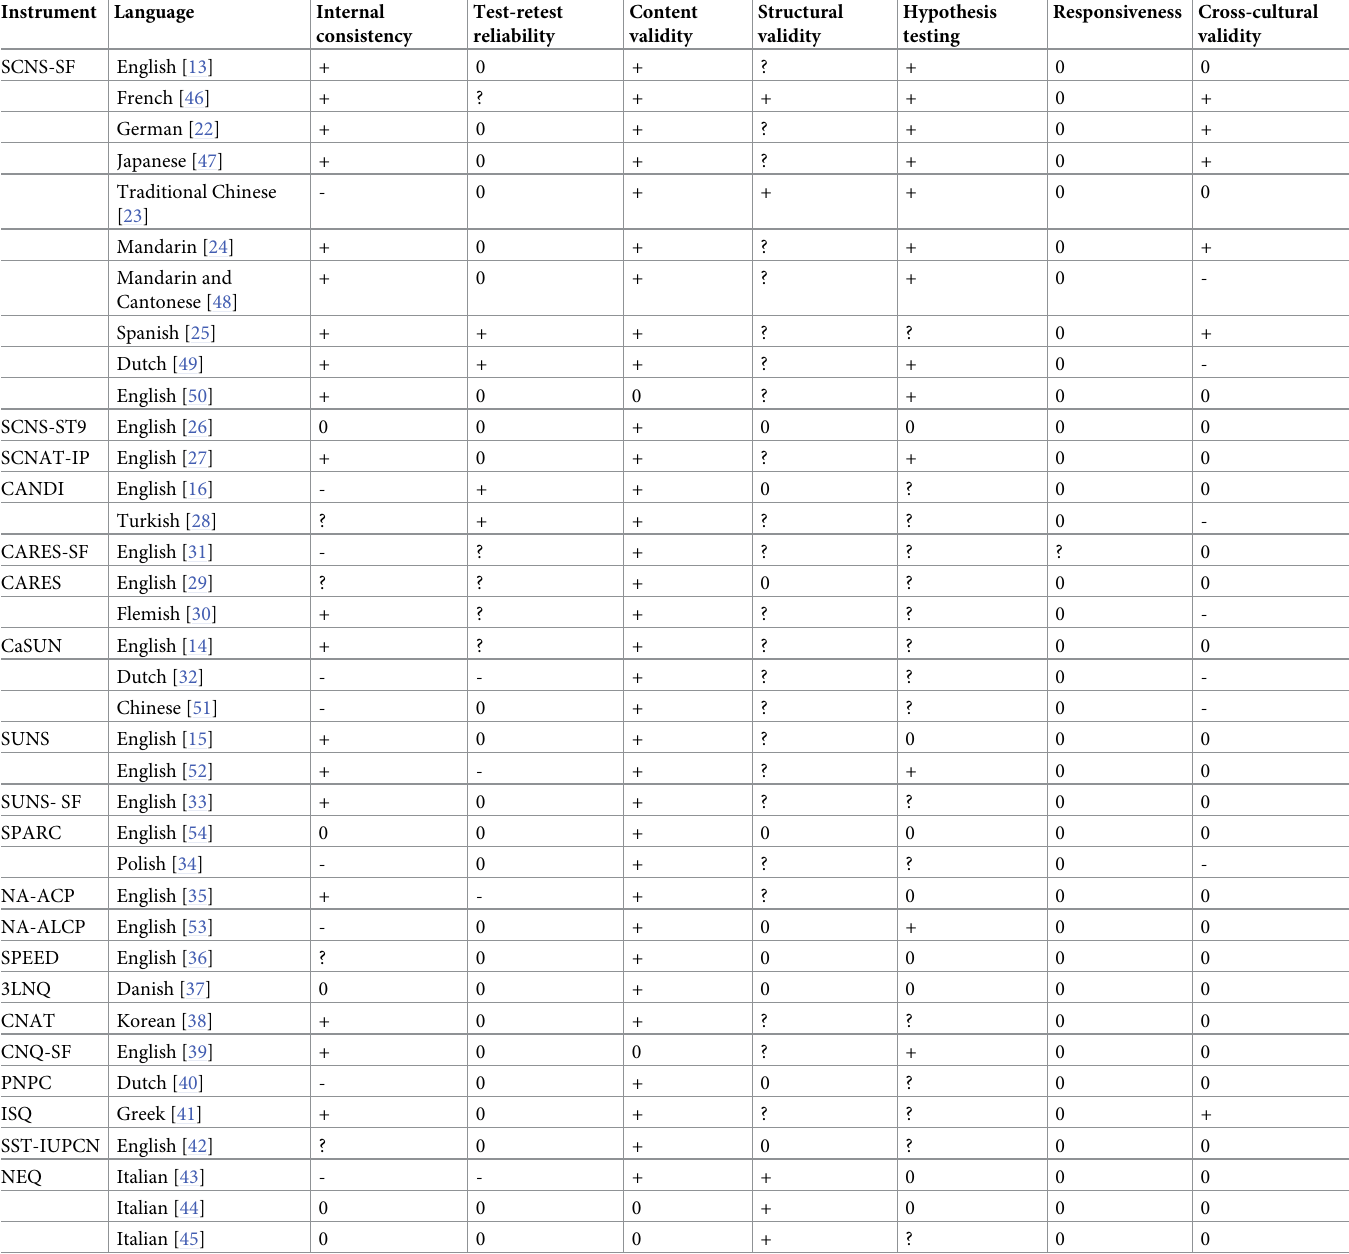
Table 3. Quality of each psychometric property of needs assessment tools in cancer patients. Instrument